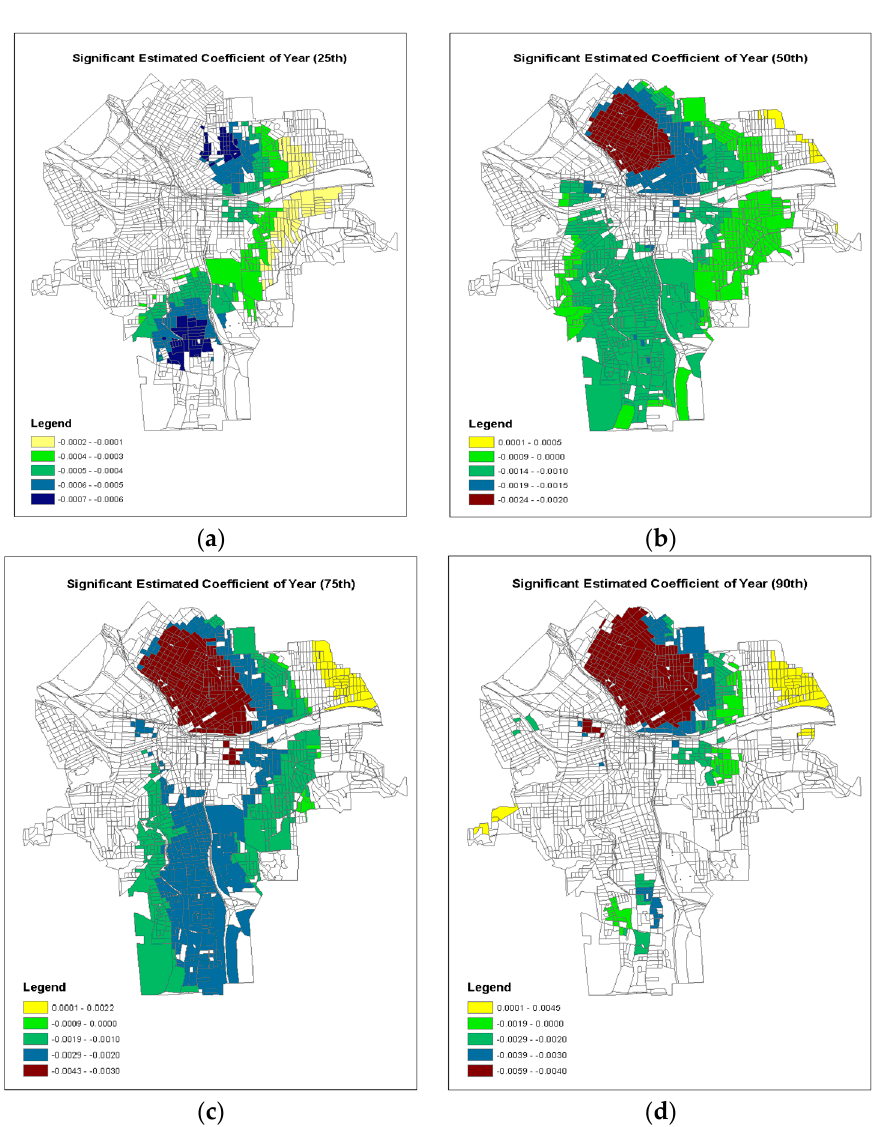
Figure 6. Geographical map of the significant coefficients (±1.96) of GWQR for Building Year: ( a ) 25th; ( b ) 50th; ( c ) 75th; ( d ) 90th.